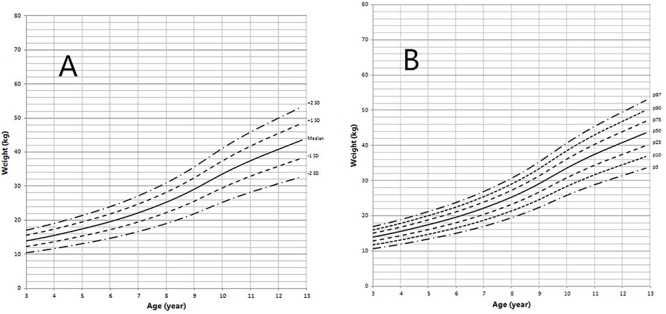
Weight in children with 5αRD (3–13 years old). (A) Standard deviation curve; (B) Percentile curve.